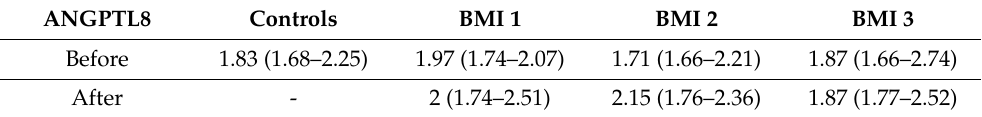
Table 3. Comparison between ANGPTL8 serum concentrations before and after treatment in sub- Table 4. Comparison between ANGPTL8 serum concentrations before and after treatment with groups of psoriatic patients divided according to BMI, and in controls without psoriasis. acitretin and methotrexate separately in psoriatic patients, and in controls without